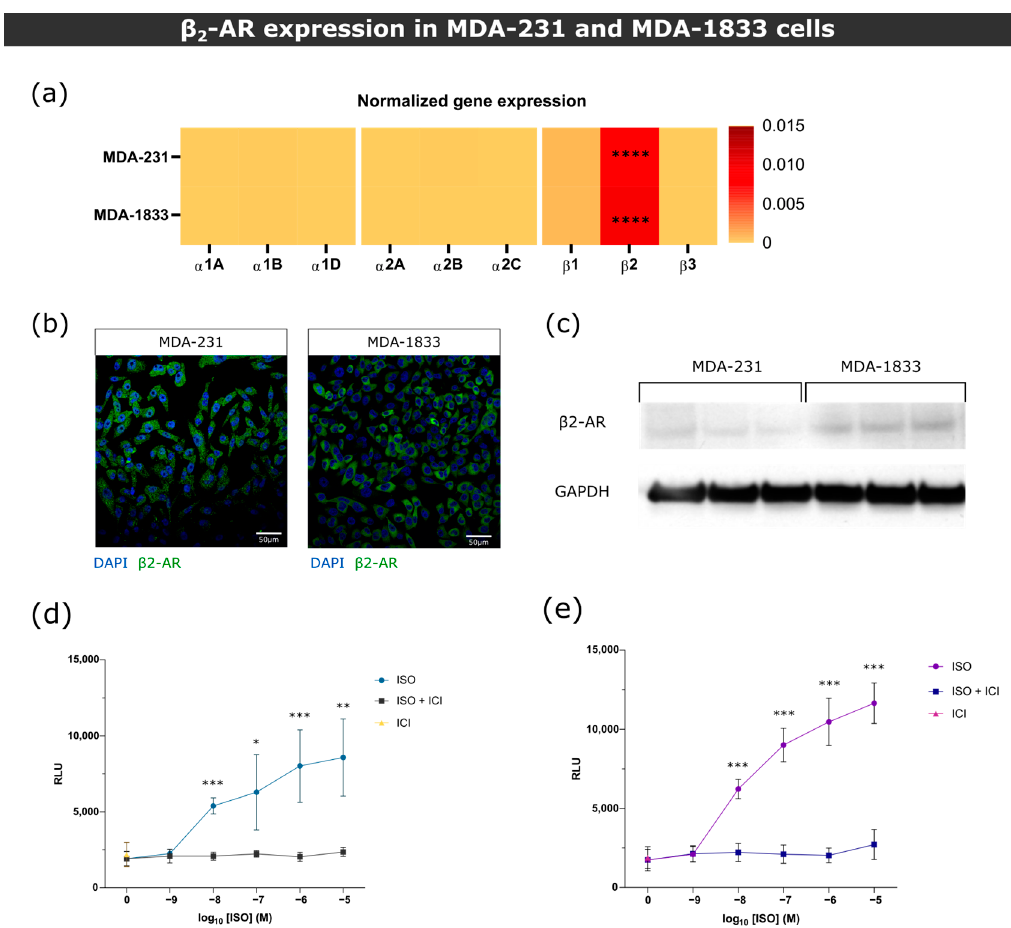
Figure 1. β 2-AR gene and protein expression in MDA-231 and MDA-1833 cells. ( a ) Normalized gene expression of ARs in primary MDA-231 and metastatic MDA-1833 cell lines performed by real time PCR. One-way ANOVA with Holm–Šídák’s multiple comparison test was used to compare β 2-AR expression to every other ARs in MDA-231 or MDA-1833 ( n = 6, **** p < 0.0001). No significant differences were found in AR expression between MDA-231 and MDA-1833 cells (two-way ANOVA with Šídák’s multiple comparison test). ( b ) Representative micrograph of the expression of β 2-AR on MDA-231 cells (left) and MDA-1833 cells (right) by immunocytochemistry. Nuclei—blue; β 2-AR—green. Scale bar—50 µm. ( c ) Expression of β 2-AR on MDA-231 and MDA-1833 cells by Western blot. Uncropped blot can be found in Figure S4. ( d ) Stimulation of MDA-231 or ( e ) MDA-1833 cells with ISO results in cAMP accumulation, which is abrogated by the incubation with 1 µM ICI. Data were generated from three experiments performed in triplicate (Mann–Whitney test, * p < 0.05, ** p < 0.01, *** p < 0.001).